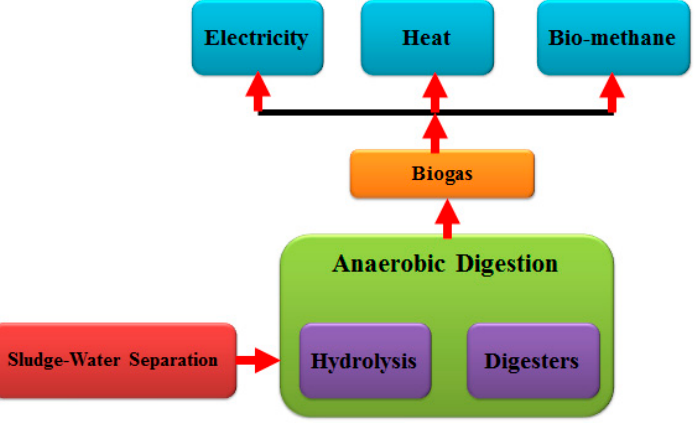
Figure 8. Main steps of anaerobic digestion in WWTPs.